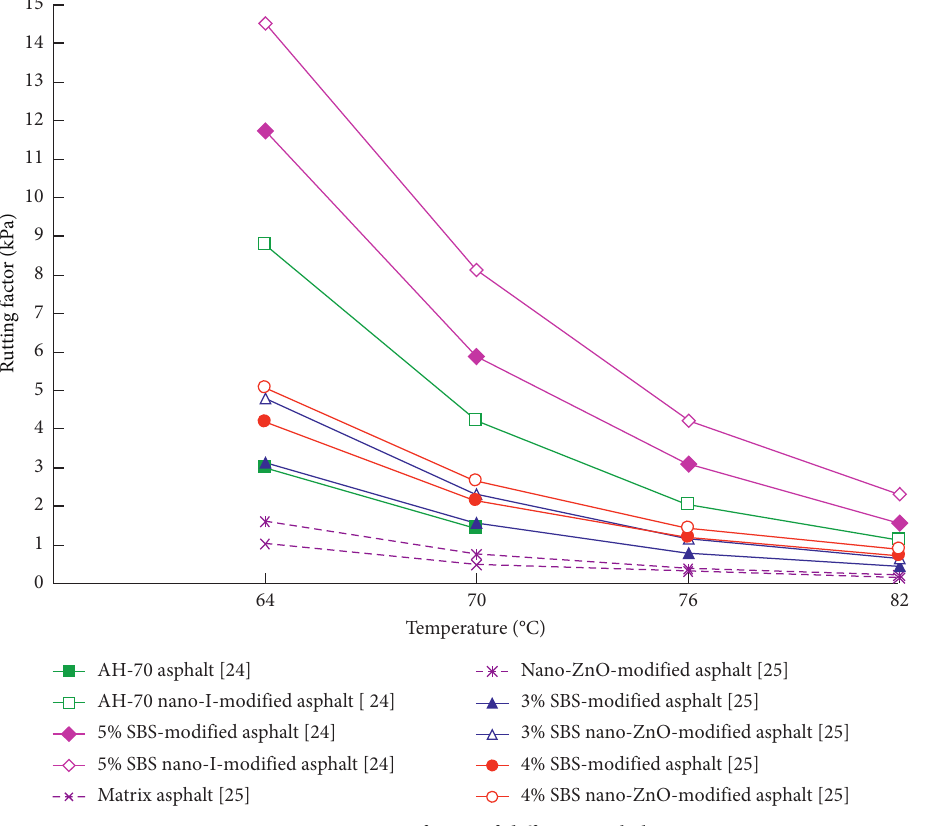
Figure 3: Rutting factor of different asphalt.